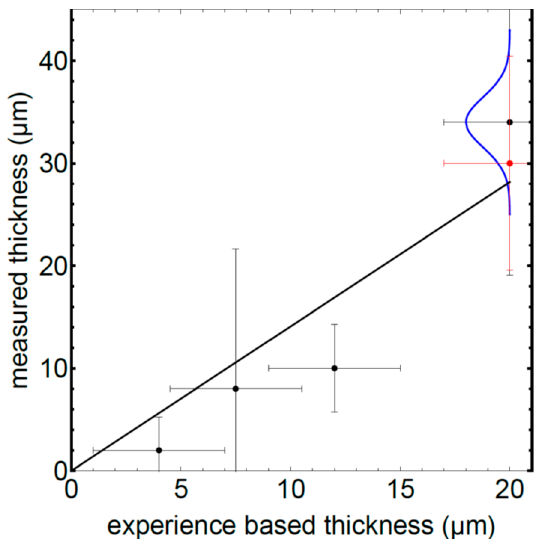
Figure 11. Results of tests. Black points: measured coating thickness with LIBS as a function of the appointed thickness. The x-values are experience-based values for the used parameters of the plasma chamber. The typical error is 3 µ m. The y-values show the median of the measurements with the LIBS system. The red dot shows a reference measurement with a micrometer screw gauge. The blue curve shows the result of a 3d surface map measured with a laser scanning microscope.